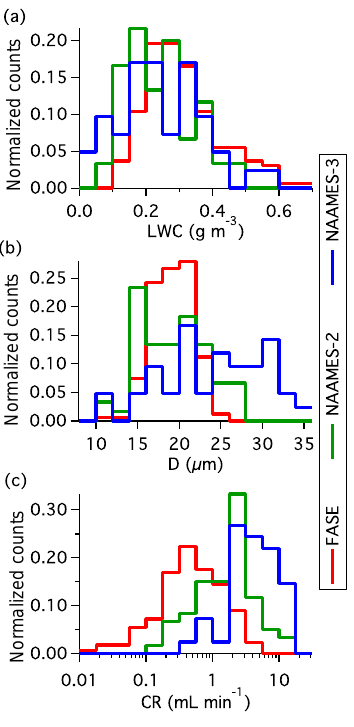
Figure 8. Campaign histograms showing the variability of (a) LWC, (b) effective diameter ( D ), and (c) collection rate (CR).